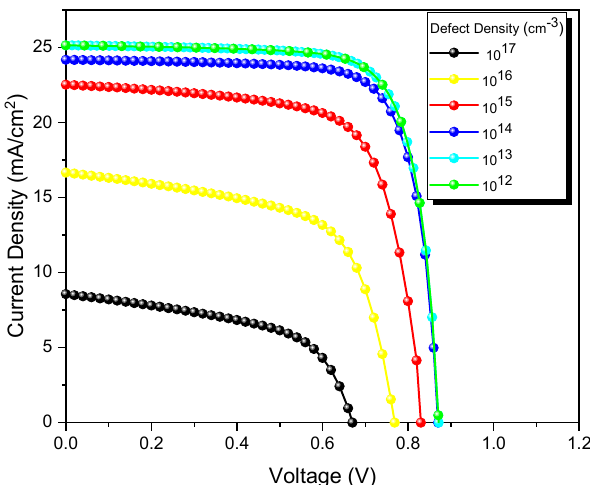
Figure 6. J-V curves of CdTe solar cells at different bulk defect densities of the CdTe layer.